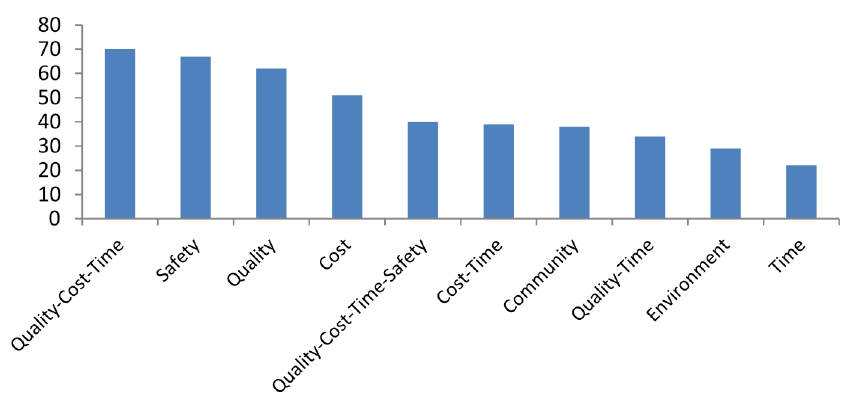
Figure 3. Innovation classification based on Benefit.